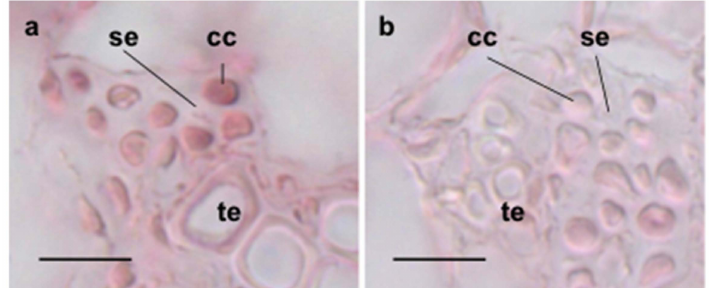
Figure 2. In situ hybridization of ASN3 mRNA in Arabidopsis leaves with ( a ) antisense ASN3 mRNA and ( b ) control sense ASN3 mRNA. Digoxigenin (DIG)-UTP-labeled in situ hybridization signals were detected by microscopy. cc: companion cell, se: sieve element, te: tracheary element. Bar = 20 µ